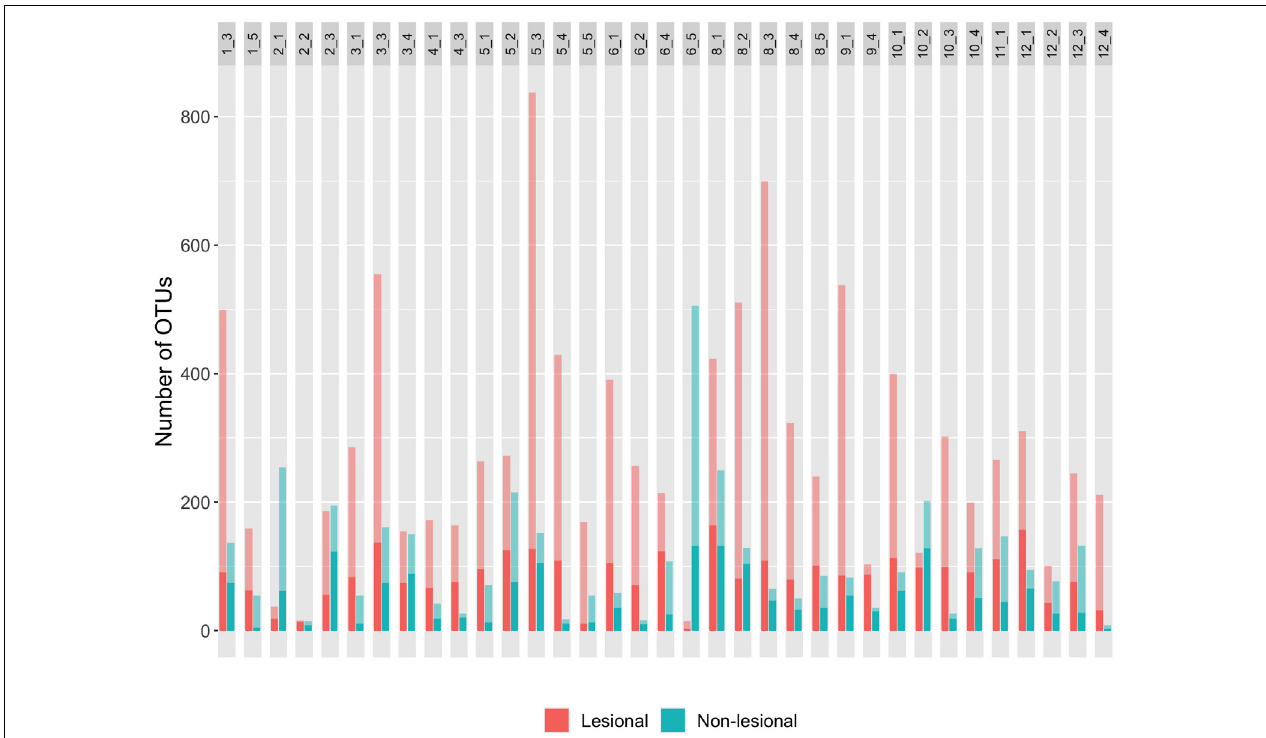
FIGURE 4 | This plot contains the OTU richness of pairs (pair ID listed at the top of the respective bars) from rarefied data ( Supplementary Figure S3 for non-rarefied OTU richness data). The number (X_X) in the gray box represents the sample pair, where the first X represents the transect number and the second X is the coral number. Thus, 1_3 is a coral pair containing a sample of the non-lesional and lesional tissues from the third coral on the first transect. The color of the bar represents the lesion status of the sample. The translucent coloration represents the theoretical maximum (Choa1 estimate) whereas, solid coloration is representative of OTU richness of rarefied data. Overall, lesional samples have more OTUs than their adjacent non-lesional